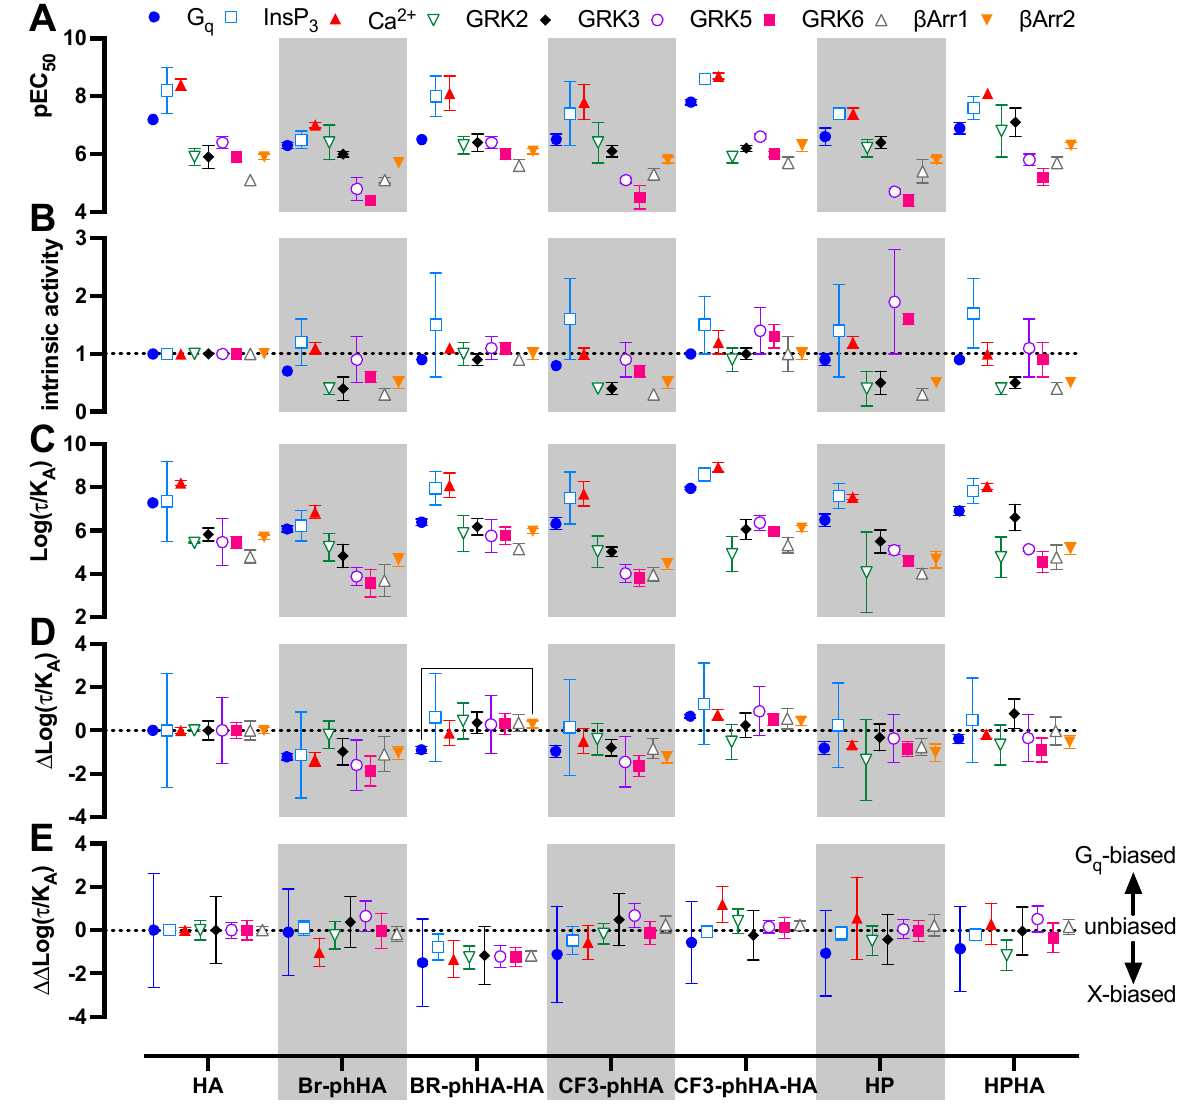
Figure 6. Biased activities of agonists in BRET-based H 1 R responses in transfected HEK293T cells. The pEC 50 ( A ) and intrinsic activity ( B ) values obtained from the concentration response curves in Figure 5 (Supplementary Tables S1 and S2). Intrinsic activities were calculated versus reference full agonist histamine. Transduction ratio (Log( τ /K A ) ( C ), relative effectiveness ( ∆ Log( τ /K A ) ( D ) and Log bias factor ( ∆∆ Log( τ /KA) ( E ) as calculated after analyzing the concentration response curves in Figure 5 using the operational model of agonism to retrieve the transduction ratio (Log( τ /K A ; Supplementary Table S3), followed by normalization to the reference full agonist histamine ( ∆ Log( τ /K A ; Supplementary Table S4) and comparison of the various functional readouts to the G q activation response ( ∆∆ Log( τ /K A ; Supplementary Table S5). Data are shown as mean ± SD from at least three independent experiments performed in triplicate. Statistical differences ( p < 0.05) between relative effectiveness of each ligand in the tested responses were determined using Welch ANOVA with Dunnett’s T3 multiple comparison test and are indicated by an